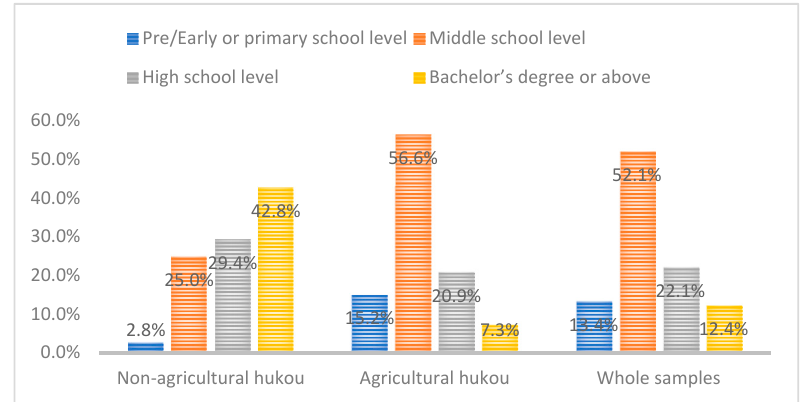
Figure 1. Education levels of various samples.